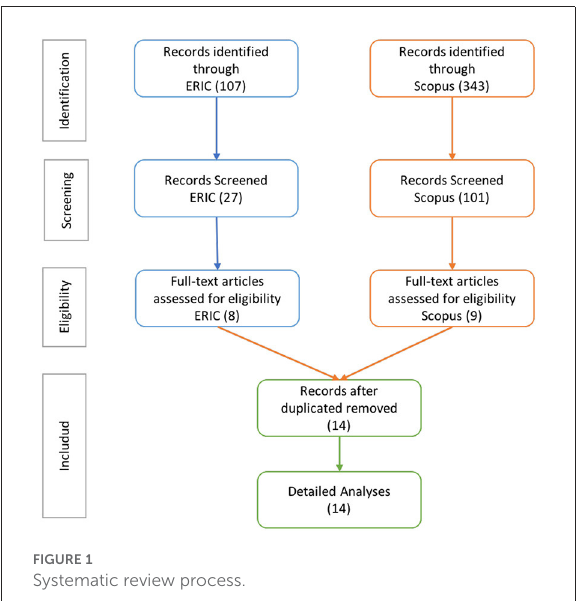
FIGURE1 Systematic review process.